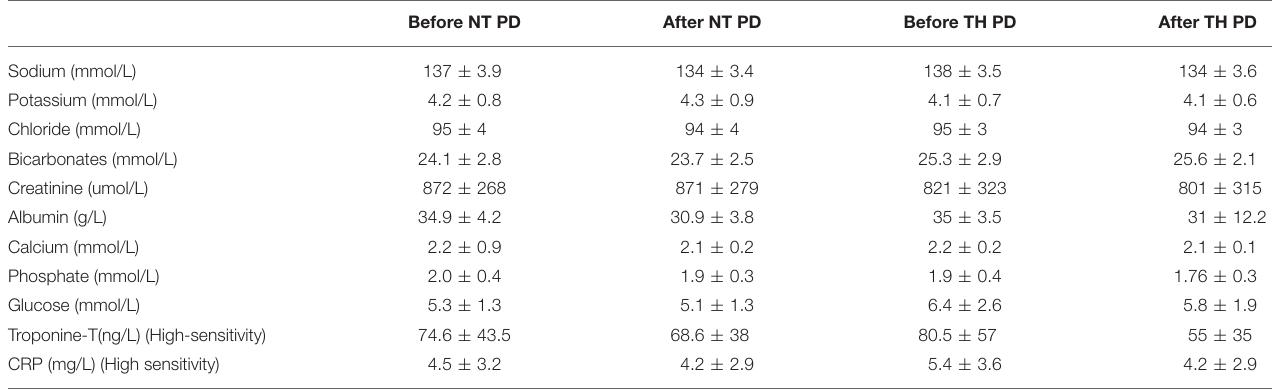
TABLE 1 | Patients’ characteristics: anthropometrics values, medical history and medications.